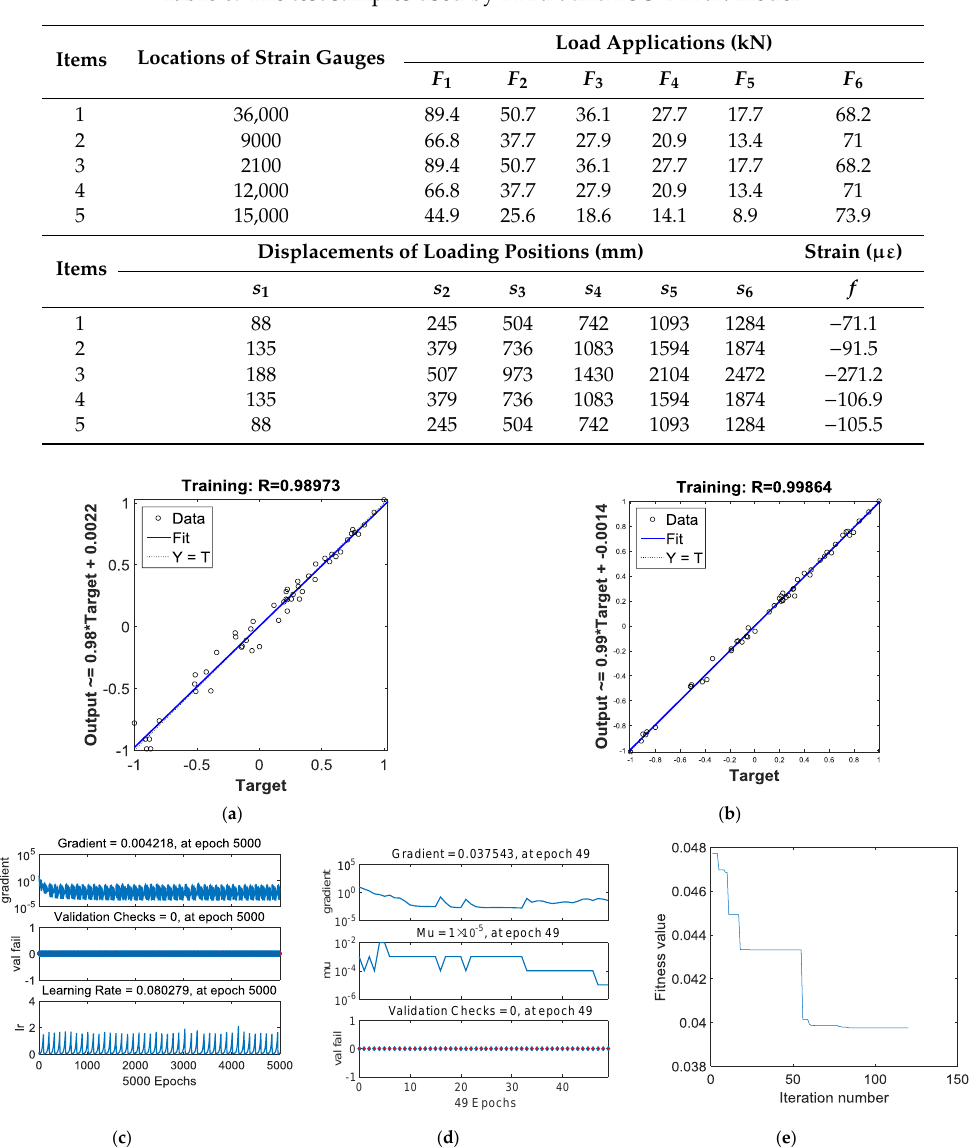
( b ) ( c ) Figure 8. ( a ) Fitting results comparison of the training set by BPNN; ( b ) fitting results comparison of the training set by PSO-BPNN; ( c ) errors comparison of test set by BPNN and PSO-BPNN. Figure 8a,b presents the comparison of fitting effects based on the training samples analyzed by BPNN and PSO-BPNN, respectively. They show that the fitting effects of PSO-BPNN are better compared to BPNN. Besides, in order to verify the fitting and predictive abilities of the PSO-BPNN and BPNN algorithms, the result of errors comparison with the true values is shown after the test samples are trained by the two different algorithms in Figure 8c. In Figure 8c, we can see that the PSO-BPNN model has much higher accuracy according to the test results, and its rates of relative errors outputted according to the test sample training are below 6%, while the relative error rates of BPNN models are below 18%, so PSO-BPNN shows a better performance of predictive ability than BPNN. 4.2. Strain Prediction Modeling for the Central of Pressure Side on Edgewise− The methodology is the same as that used in Section 4.1. A strain-predictive PSO-BPNN model for the center of the pressure side loaded on the direction of edgewise− is established. The training samples and test samples of the strain-predictive PSO-BPNN model are shown in Tables 7 and 8, respectively. Table 7. The training samples trained by BPNN and PSO-BPNN